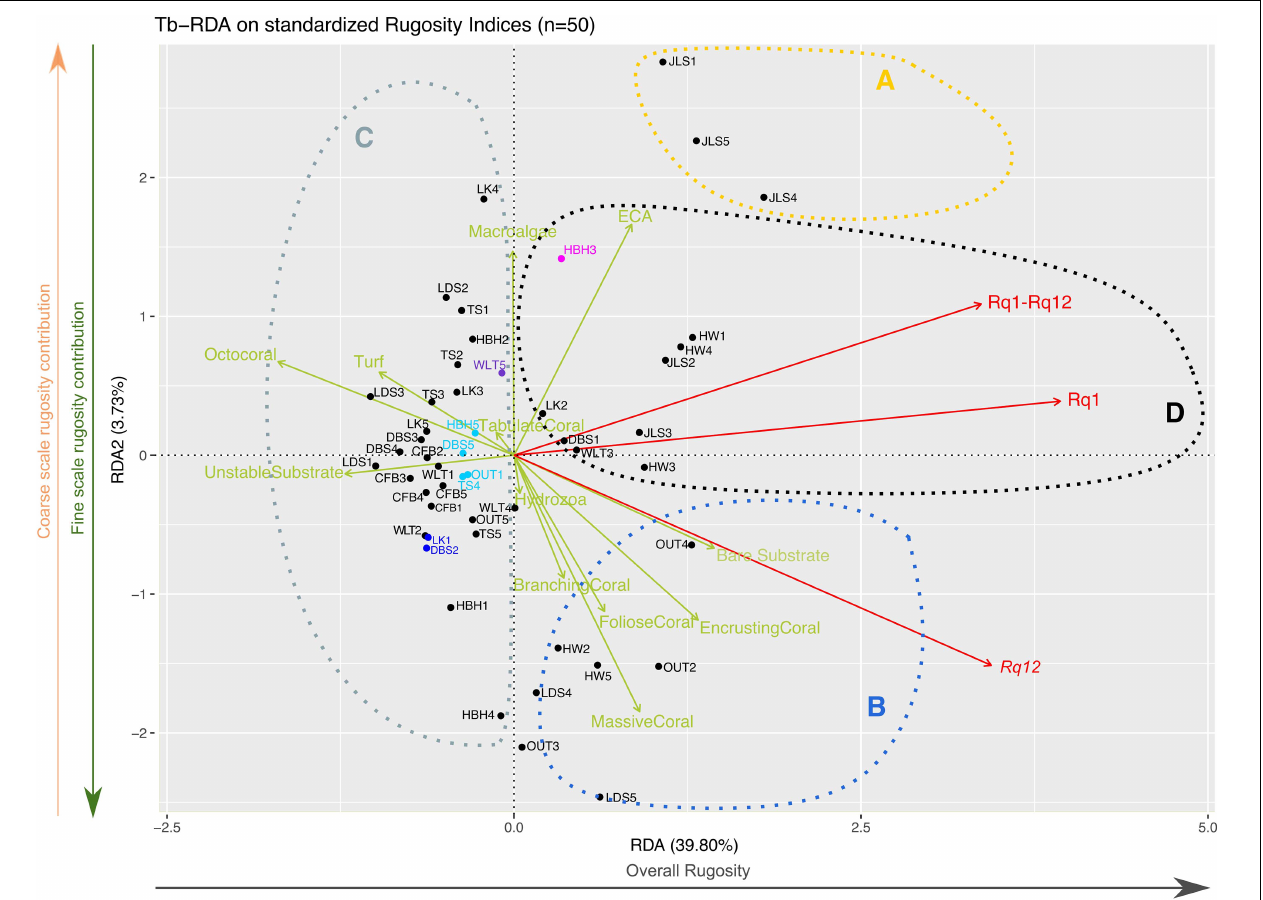
FIGURE 8 | Constrained tb-RDA of transects’ rugosity with their benthic compositions. Red vectors represent the contributions of the rugosity indices to the tb-RDA, while the green vectors represent the benthic categories constraining the tb-RDA. The gray arrow under the x -axis illustrates the overall rugosity gradient between transects, while the green and orange arrows beside the y -axis represent the fine and coarse scale rugosity gradients, respectively. Dashed circles represent the proposed target transect groups used to illustrate potential management strategies in the